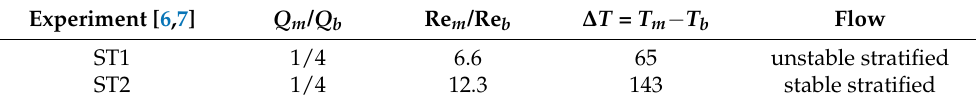
Table 2. Mixing regimes in the